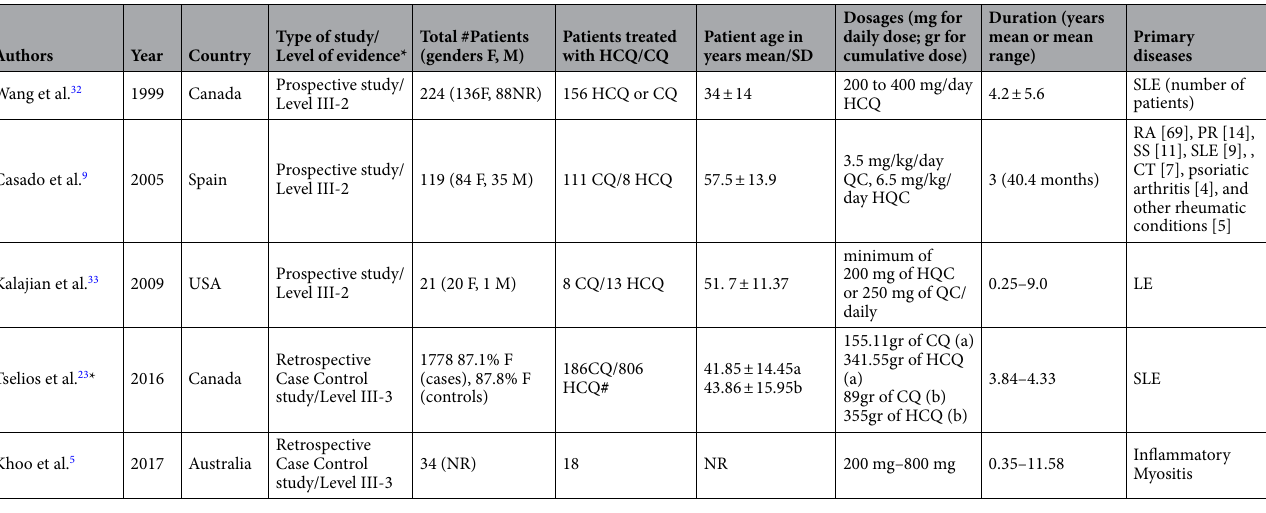
Table 1. Data summary for the six studies selected for CQ/HCQ-induced myopathy. F female, M male; Primary diseases: LE (various types of lupus Erythematosus), SLE systemic lupus erythematosus, RA rheumatoid arthritis, PR palindromic rheumatism, SS Sjogren’s syndrome, CT connective tissue disease. # Sum of group case + group control (group case are patients with elevated enzymes for muscle injury (CK) and group control is patients with non-elevation. a = case group b = control group. *Data from Tselios et al. 23 were obtained from Table 1 of the original study.